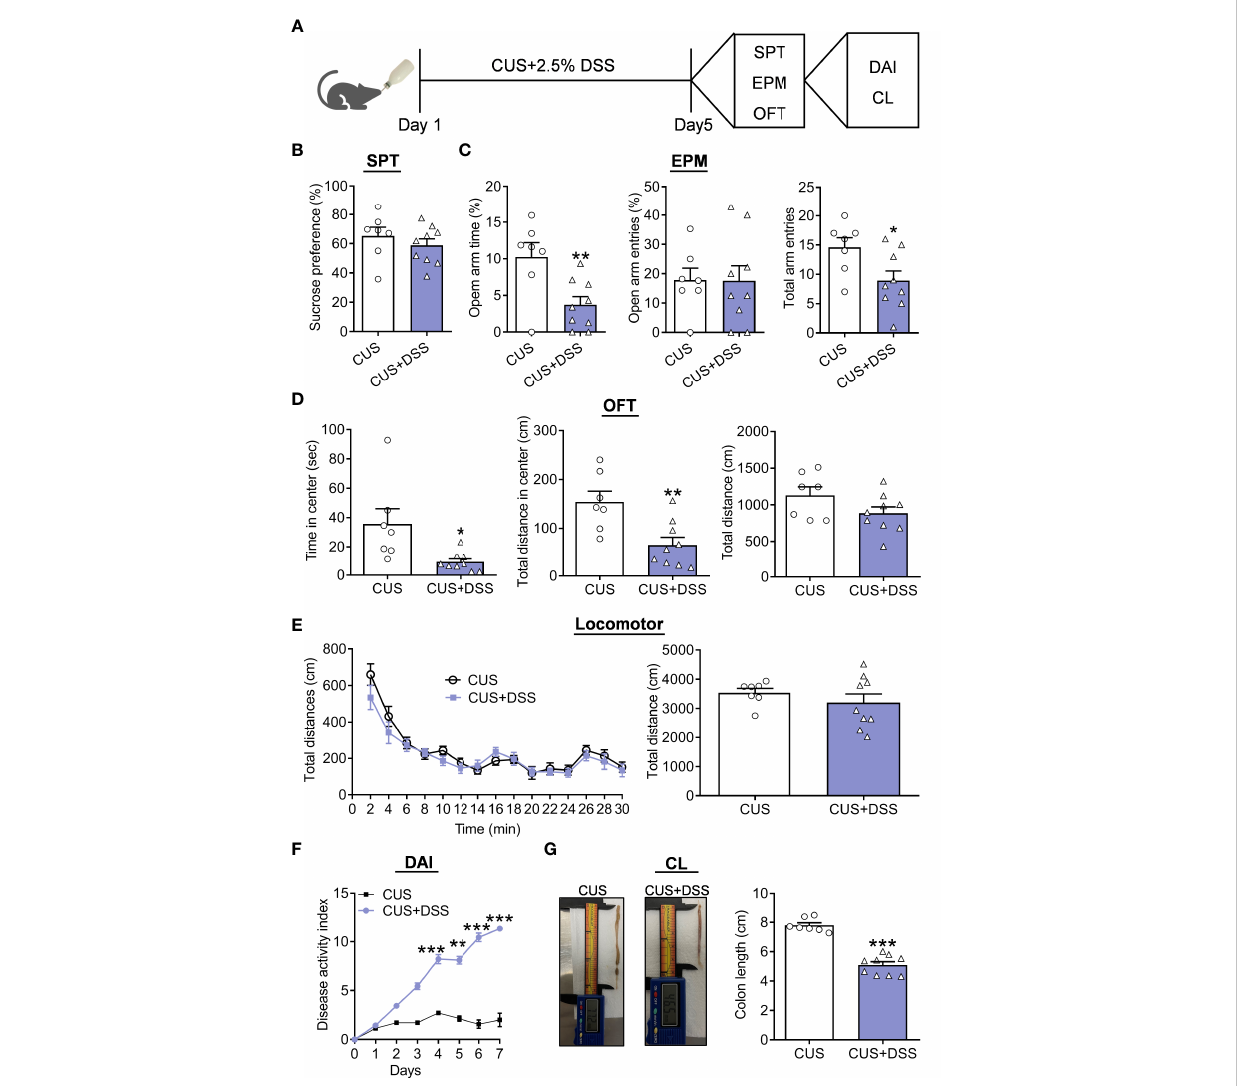
FIGURE 2 Depression/anxiety-related behaviors and colitis induced by chronic DSS/stress treatment. (A) Schematic diagram of experimental designs. (B) Sucrose preference test (SPT). (C) Elevated plus-maze test (EPM). (D) Open- fi eld test (OFT). (E) Locomotor activity. (F) Disease Activity Index (DAI). (G) Colonic length (CL). H 2 O group: n=7, DSS group: n=9. * p < 0.05, ** p < 0.01, *** p < 0.001, compared to the control